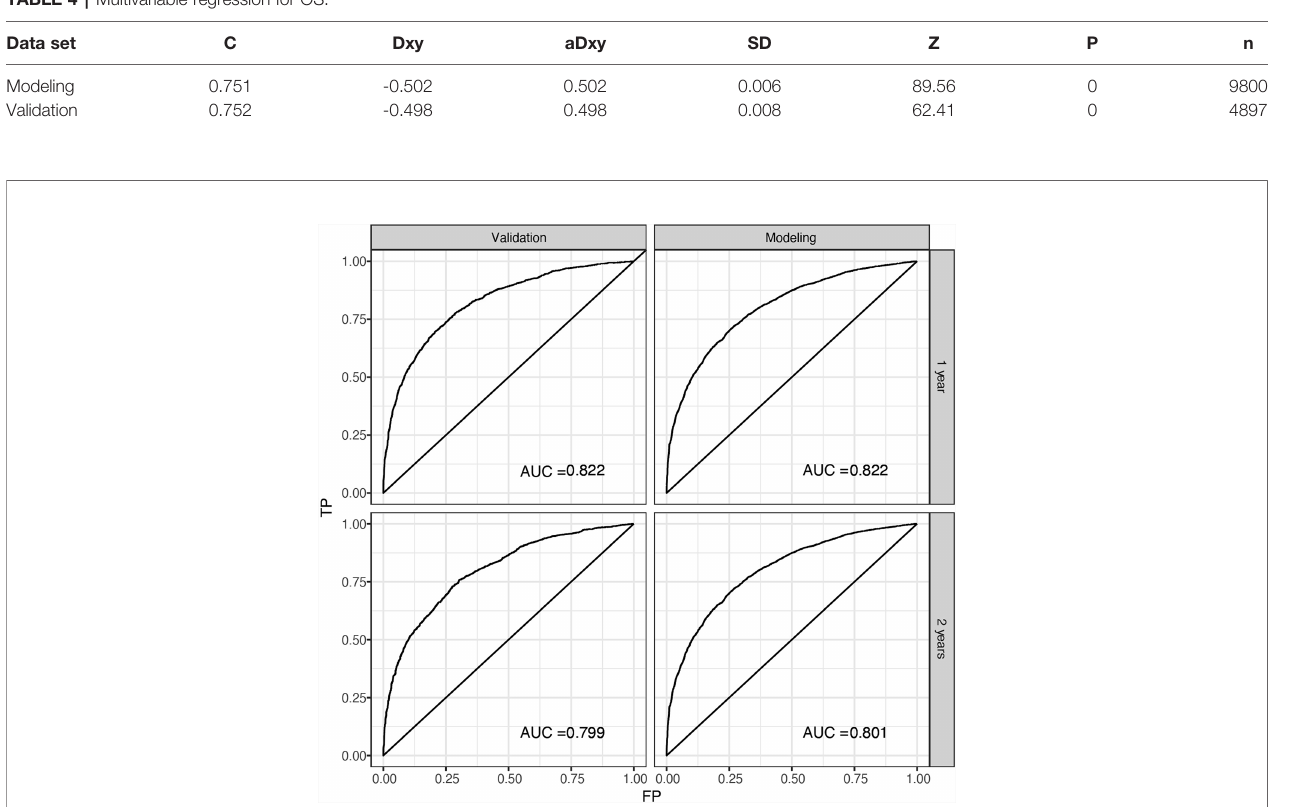
FIGURE 6 | ROC of the nomogram for 1-year and 2-year internal prediction. ROC, receiver operating curves, AUC, area under the curve; FP, false positive; TP, true